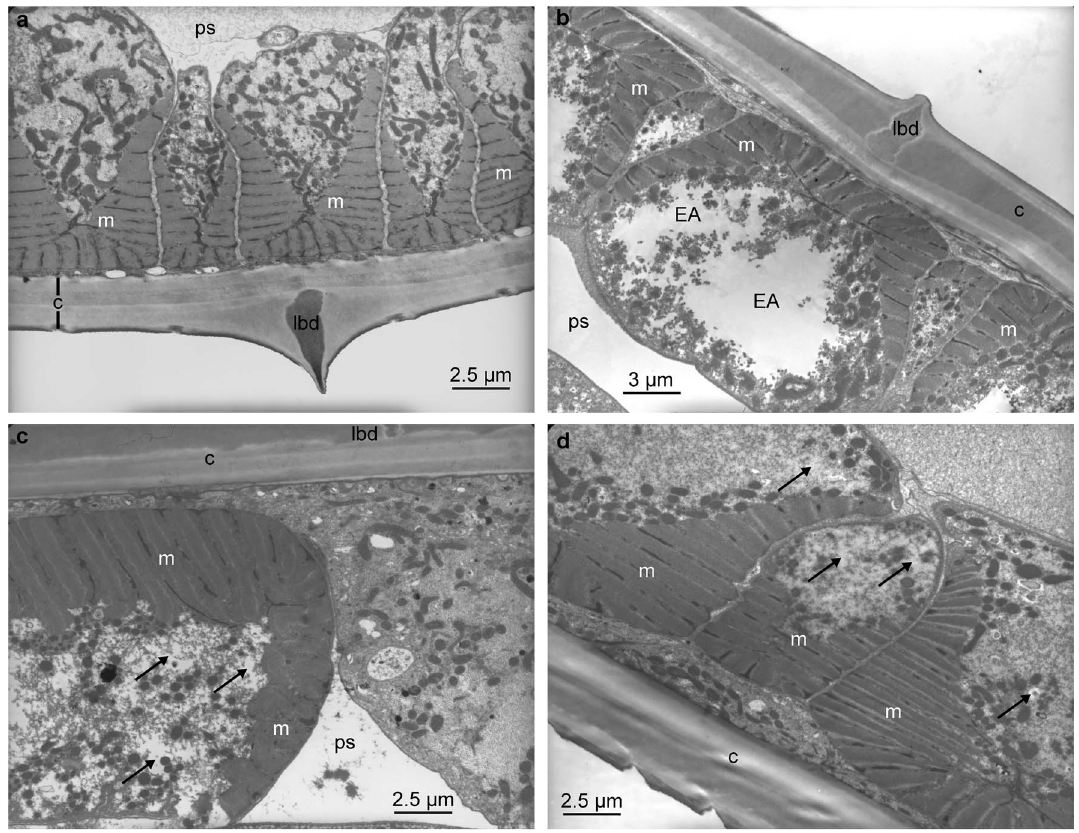
Figure 2. Transmission electron microscopy (TEM) of cuticle and muscle of Haemonchus contortus obtained from goats fed (a) control (polyphenol-free diet), (b) tzalam fodder, (c) quebracho drench or (d) sainfoin fodder. The illustrations include the longitudinal body ridge (lbd), cuticle (c), muscle cells (m), pseudocoele (ps). The main cellular lesions are electrolucent areas (EA), indicated by arrows in Figures 2c and